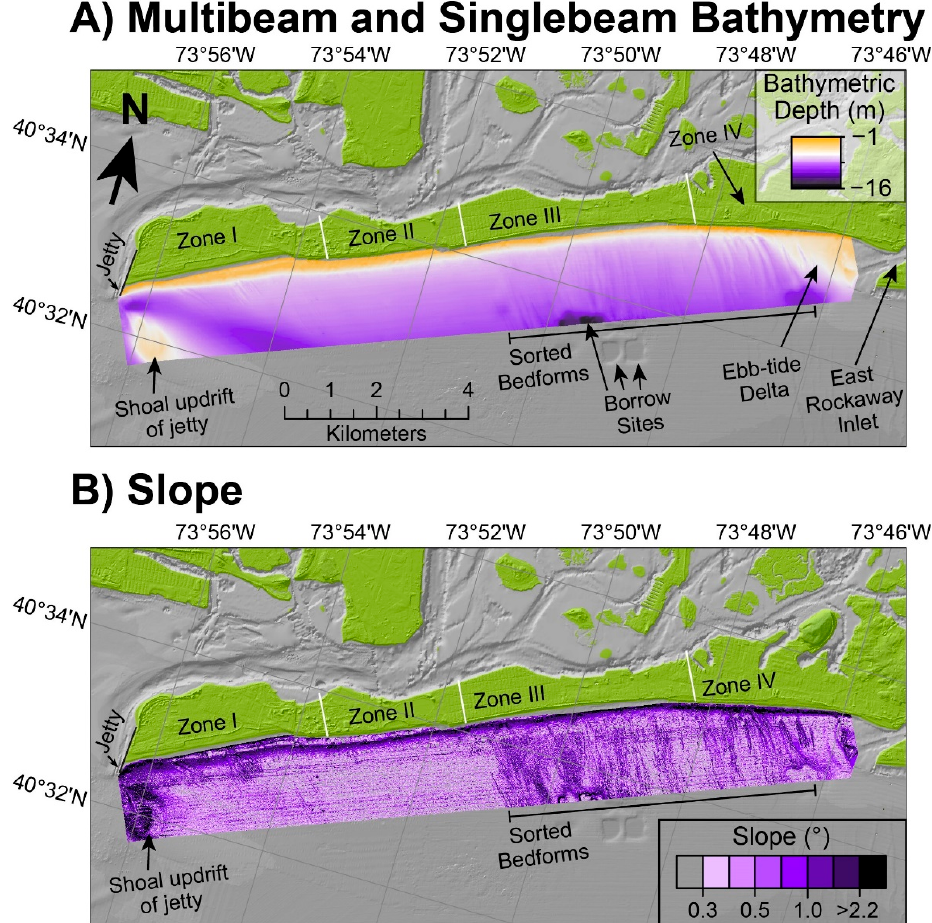
Figure 4. (A ) Digital elevation model (DEM) of multibeam and single-beam bathymetry. ( B ) Slope of the DEM in degrees. Color scale for degrees is binned in quantiles. White lines on the peninsula delineate the boundaries of the geomorphic zones.